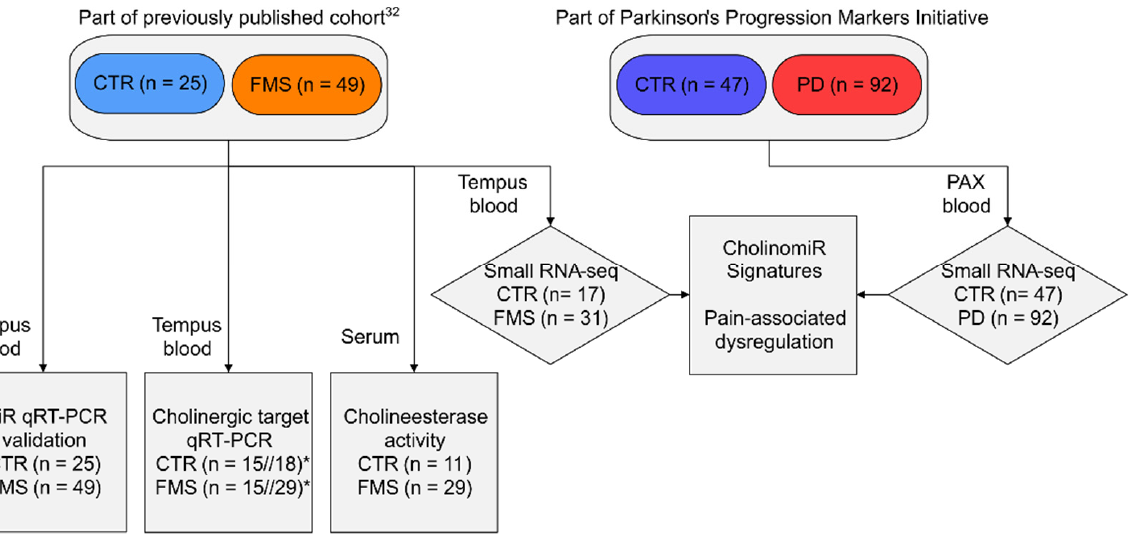
Figure 1. Study workflow. Abbreviations: CTR, healthy control; FMS, fibromyalgia syndrome; PD, Parkinson’s disease; miR, microRNA; qRT-PCR, quantitative real-time PCR. Tempus blood, blood samples collected in Tempus™ Blood RNA Tubes; PAX blood, blood samples collected in PAXgene Vacutainer tubes. * For qRT-PCR either CTR (n = 15) versus FMS (n = 15) or CTR (n = 18) versus FMS (n = 29) samples were used.